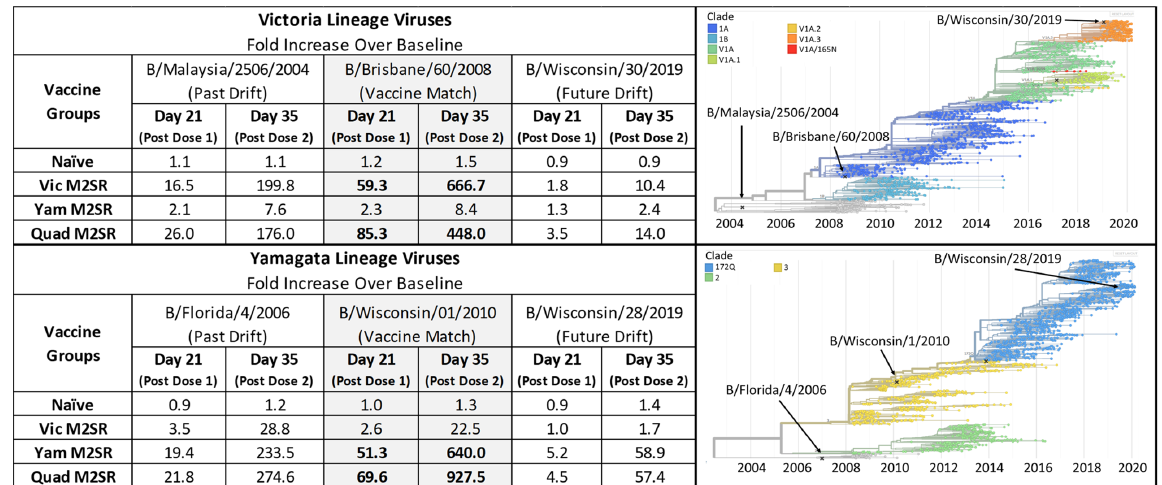
Figure 10. Fold increase serum antibody responses from BM2SR vaccinated ferrets against drifted influenza B strains. Serum was collected pre ‐ study and after 1 and 2 doses of the indicated BM2SR vaccination. Samples were tested against 3 influenza B Victoria lineage viruses (B/Malaysia/2506/2004, B/Brisbane/60/2008, and B/Wisconsin/30/2019) and 3 influenza B Yamagata lineage viruses (B/Florida/4/2006, B/Wisconsin/01/2010, and B/Wisconsin/28/2019). PRNT 50 titers were determined at each time point and averaged for the group. Values above represent the fold change in PRNT 50 titer over pre ‐ study values (baseline). Influenza B Victoria and Yamagata ‐ lineage hemagglutinin phylogenetic tree and clades are shown with the location of the tested strains indicated by arrows. Color coding and clade designations are taken from Nextstrain.org [17].